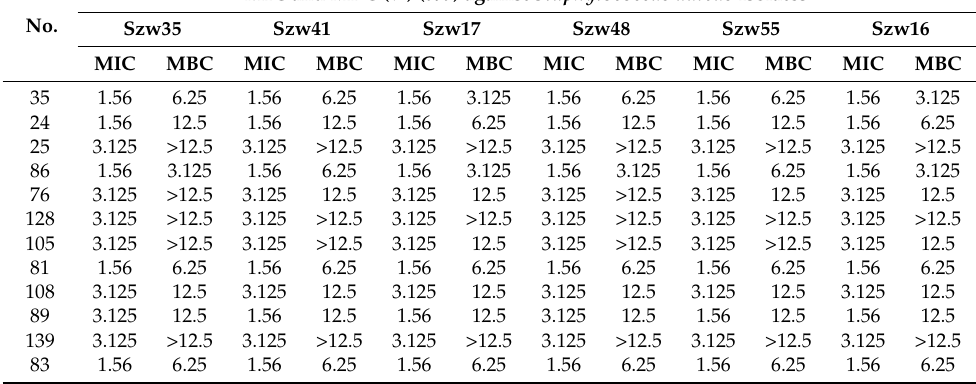
Table 3. Antibacterial activity of the most active Polish honeys against S. aureus isolates from patients with skin and soft tissue infections (SSTI): Szw35, Szw41, Szw17, Szw48, Szw55, Szw16.